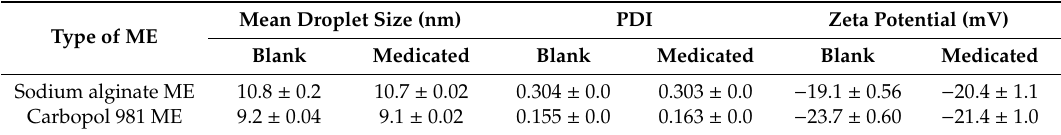
Table 2. Droplet size, polydispersity index (PDI) and zeta potential of blank and medicated ribavirin ME formulations.